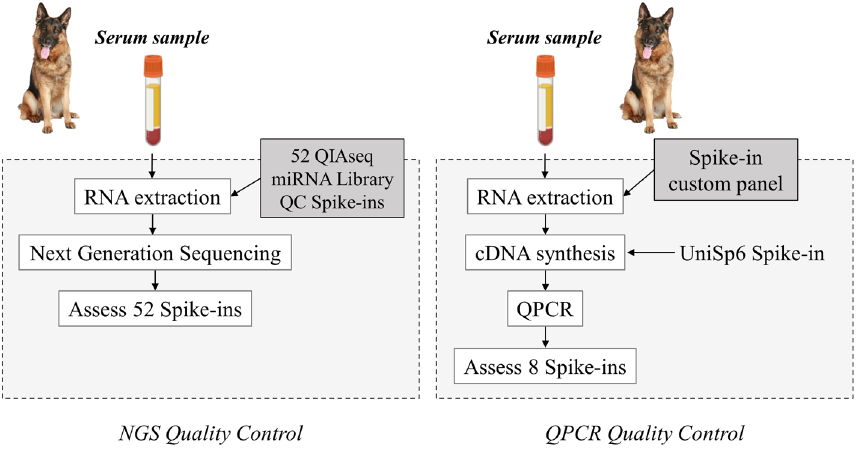
Figure 2. Quality control (QC) workflow. The NGS QC (left panel) was performed through a panel of 52 Spike- ins. The 52 RNA spike-in mix was added during RNA isolation to identify contamination and measure and validate assay parameters. In QPCR QC (right panel), 2 spike-in controls were added during RNA extraction to monitor the yield of RNA isolation, and 1 spike-in control was added to cDNA synthesis to monitor